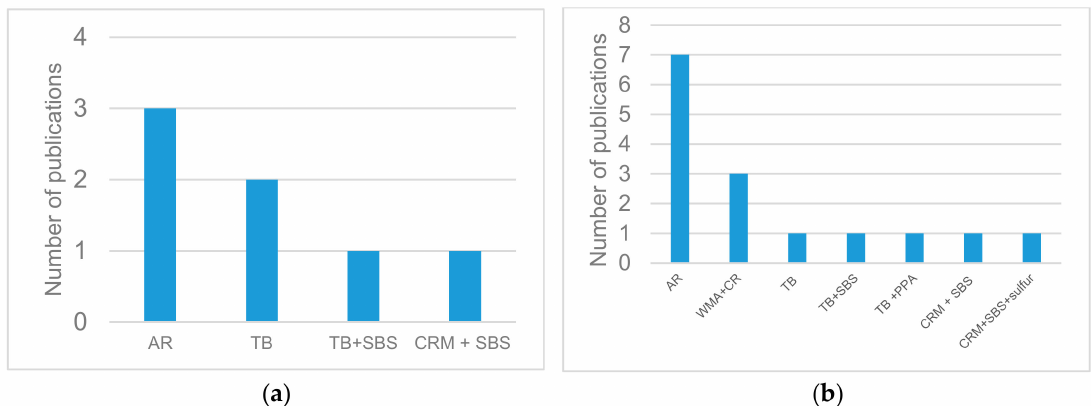
Figure 11. Comparison of rheological properties: ( a ) the number of studies reporting a higher value of the complex modulus for each CRM binder compared to traditional binder; and ( b ) the number of studies reporting a lower value of the phase angle for each CRM binder compared to the traditional